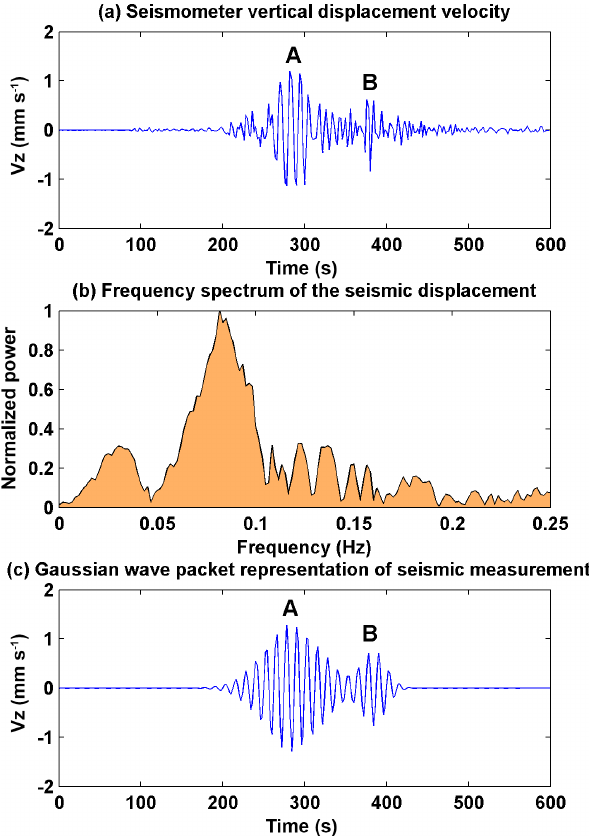
Figure 1. Seismic observations recorded at Bhuwaneshwar (20.2 ◦ N, 85.8 ◦ E) corresponding to 25 April 2015 Gorkha earth- quake (Bhuwaneshwar is located ∼ 800km south of the epicen- tre). (a) Seismometer vertical displacement velocity ( z component). A and B indicates two seismic wave packets. (b) Frequency spec- trum of the vertical displacement. (c) Gaussian wave packet repre- sentation of the seismic vertical displacement